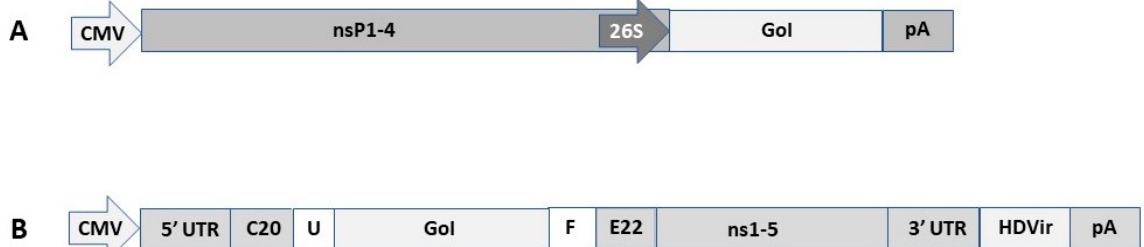
Figure 1. Schematic presentation of DNA replicon expression vectors. ( A ). Alphavirus-based DNA replicon represented by a Semliki Forest virus (SFV) vector. CMV, cytomegalovirus promoter; nsP1-4, non-structural protein genes forming the replicase complex; 26S, SFV 26S subgenomic promoter; GoI, gene of interest; pA, polyadenylation signal. ( B ). Flavivirus-based DNA replicon represented by a Kunjin virus (KUN) vector. 5 ′ UTR, 5 ′ untranslated region; C20, the first 20 amino acids of KUN C protein; U, mouse ubiquitin sequence; F, Foot-and-mouth disease virus 2A autoprotease; E22, the last 22 amino acids of KUN E protein; 3 ′ UTR, 3 ′ untranslated region; HDVr, Hepatitis delta virus ribozyme.